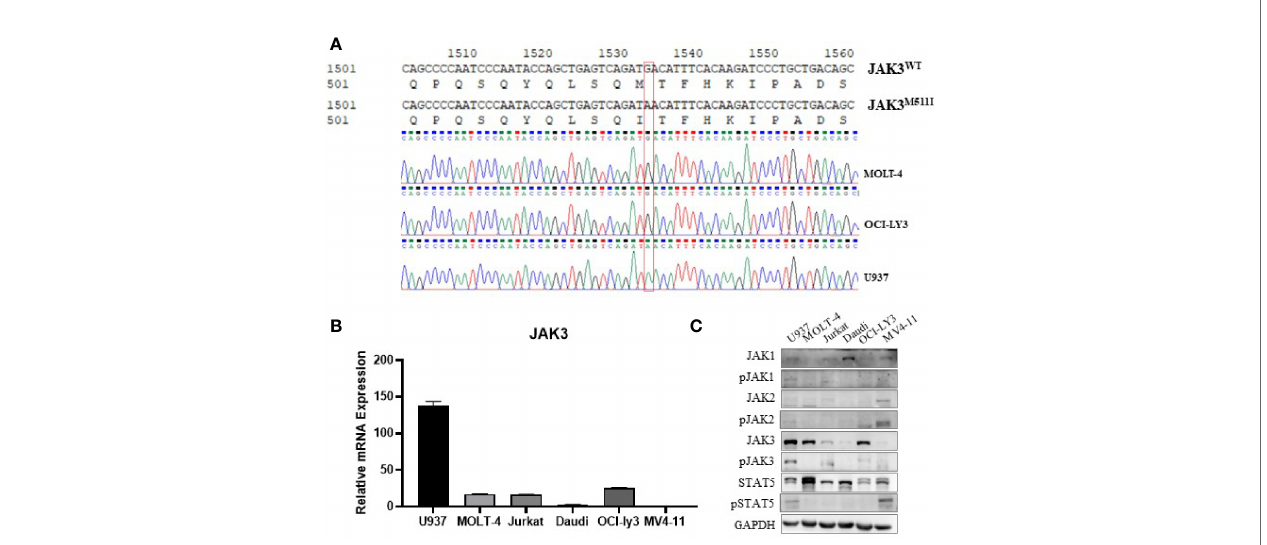
FIGURE 1 | JAK3 is M511I mutant activation in U937 cells. (A) Sanger sequencing electropherogram of the JAK3 cDNA of U937, MOLT-4, and OCI-LY3 cells. (B) Relative JAK3 mRNA expression levels in U937, MOLT-4, Jurkat, Daudi, OCI-LY3, and MV4-11 cell lines. (C) The activation of JAK3-STAT3/5 signal pathway between different cell lines (U937, MOLT-4, Jurkat, Daudi, OCI-LY3, and MV4-11) was compared by Western